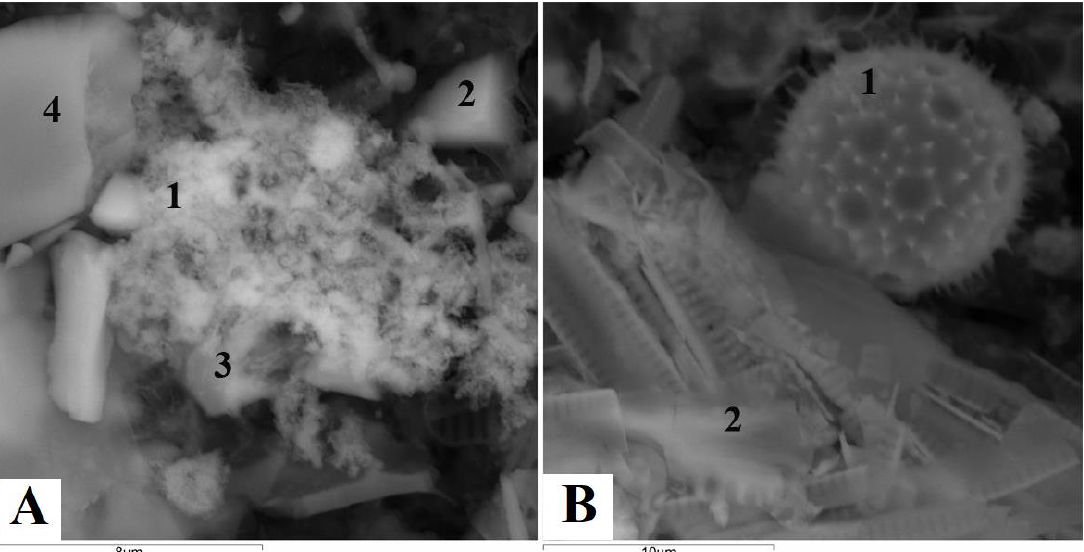
Figure 6. Micrographs made using SEM of samples of river suspended matter on filters taken in the Andoma River ( A ) and the Lososinka River ( B ): ( A ) 1 — coarse-flaked Mg-Fe chlorite aggregate and 2 — latent-flaked ferruginous chlorite grains; ( B ) 1 — fine-flaked Mg-Fe illite aggregate, 2 — latent scaly grains of Fe illite and 3 — a fine-fiber aggregate of Mn oxides.